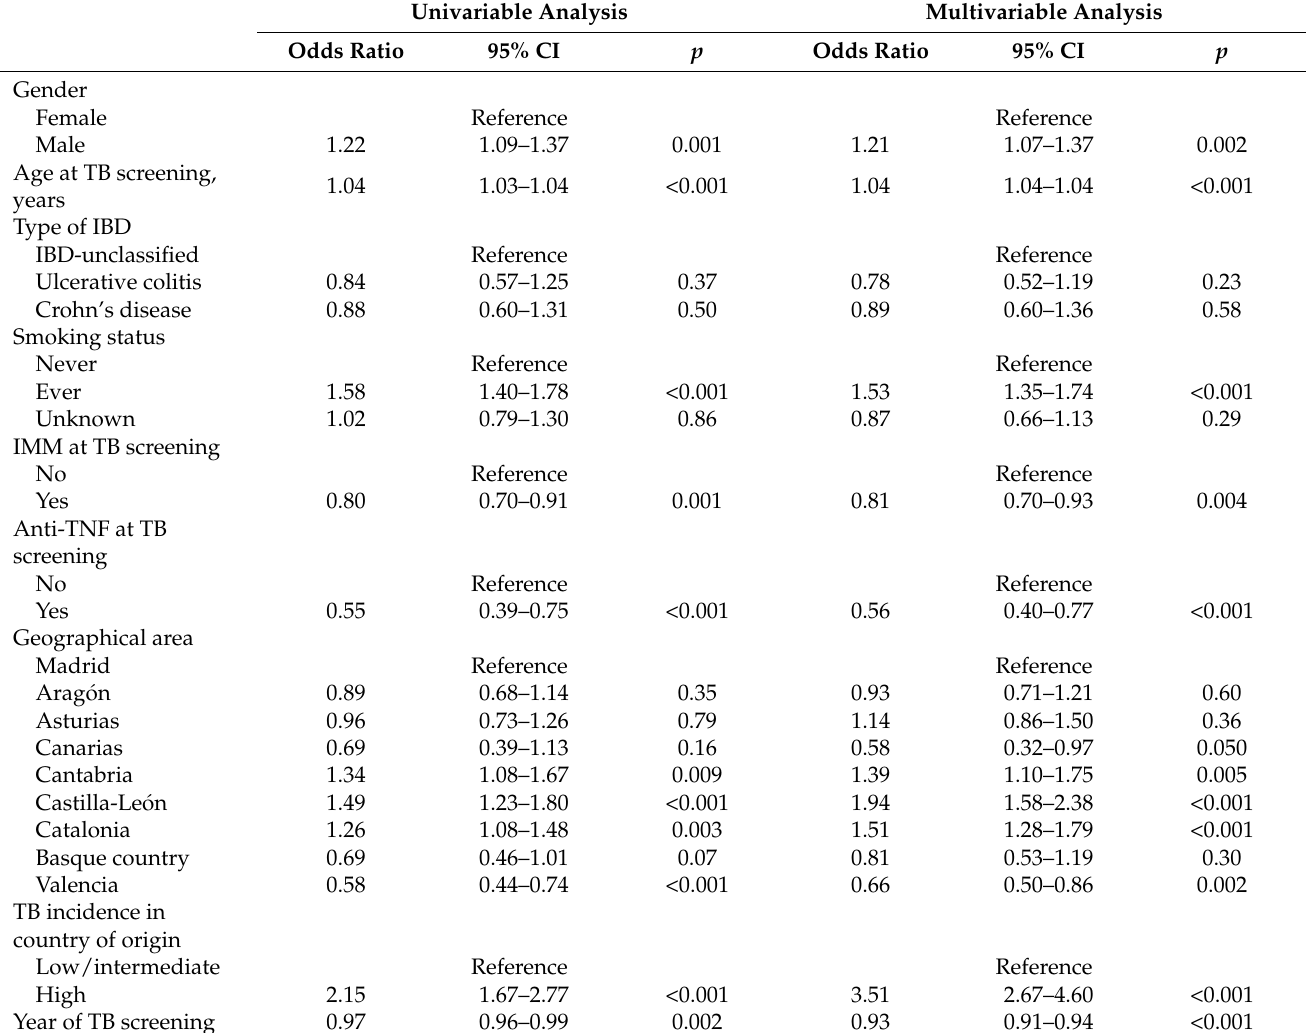
Table 3. Factors associated with diagnosis of LTBI in patients with IBD. Univariable Analysis Multivariable